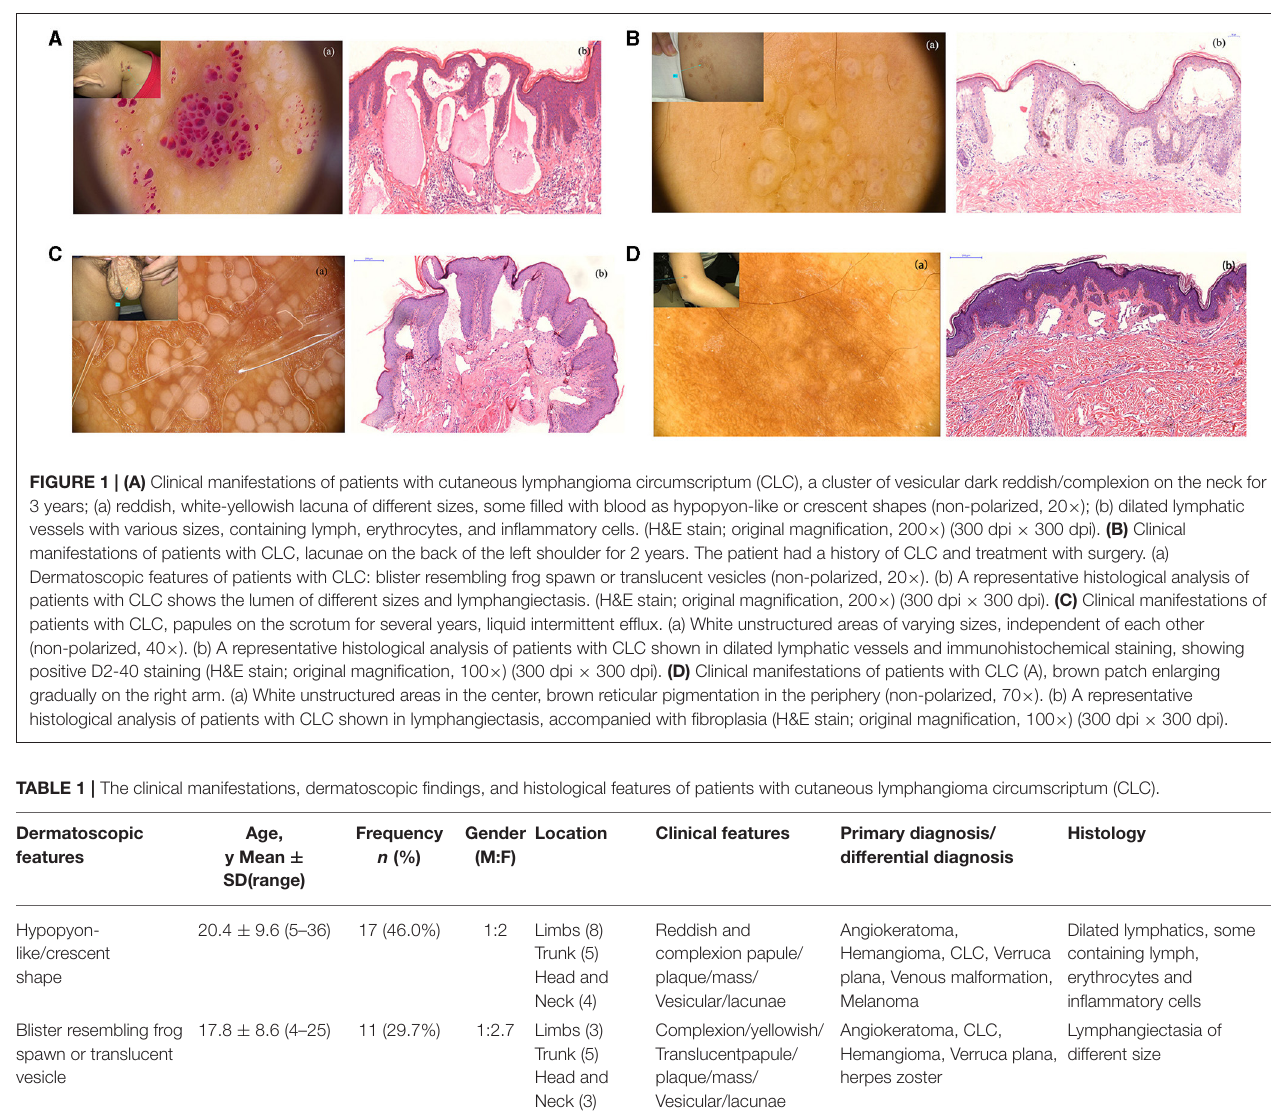
Clinical features Primary diagnosis/ differential